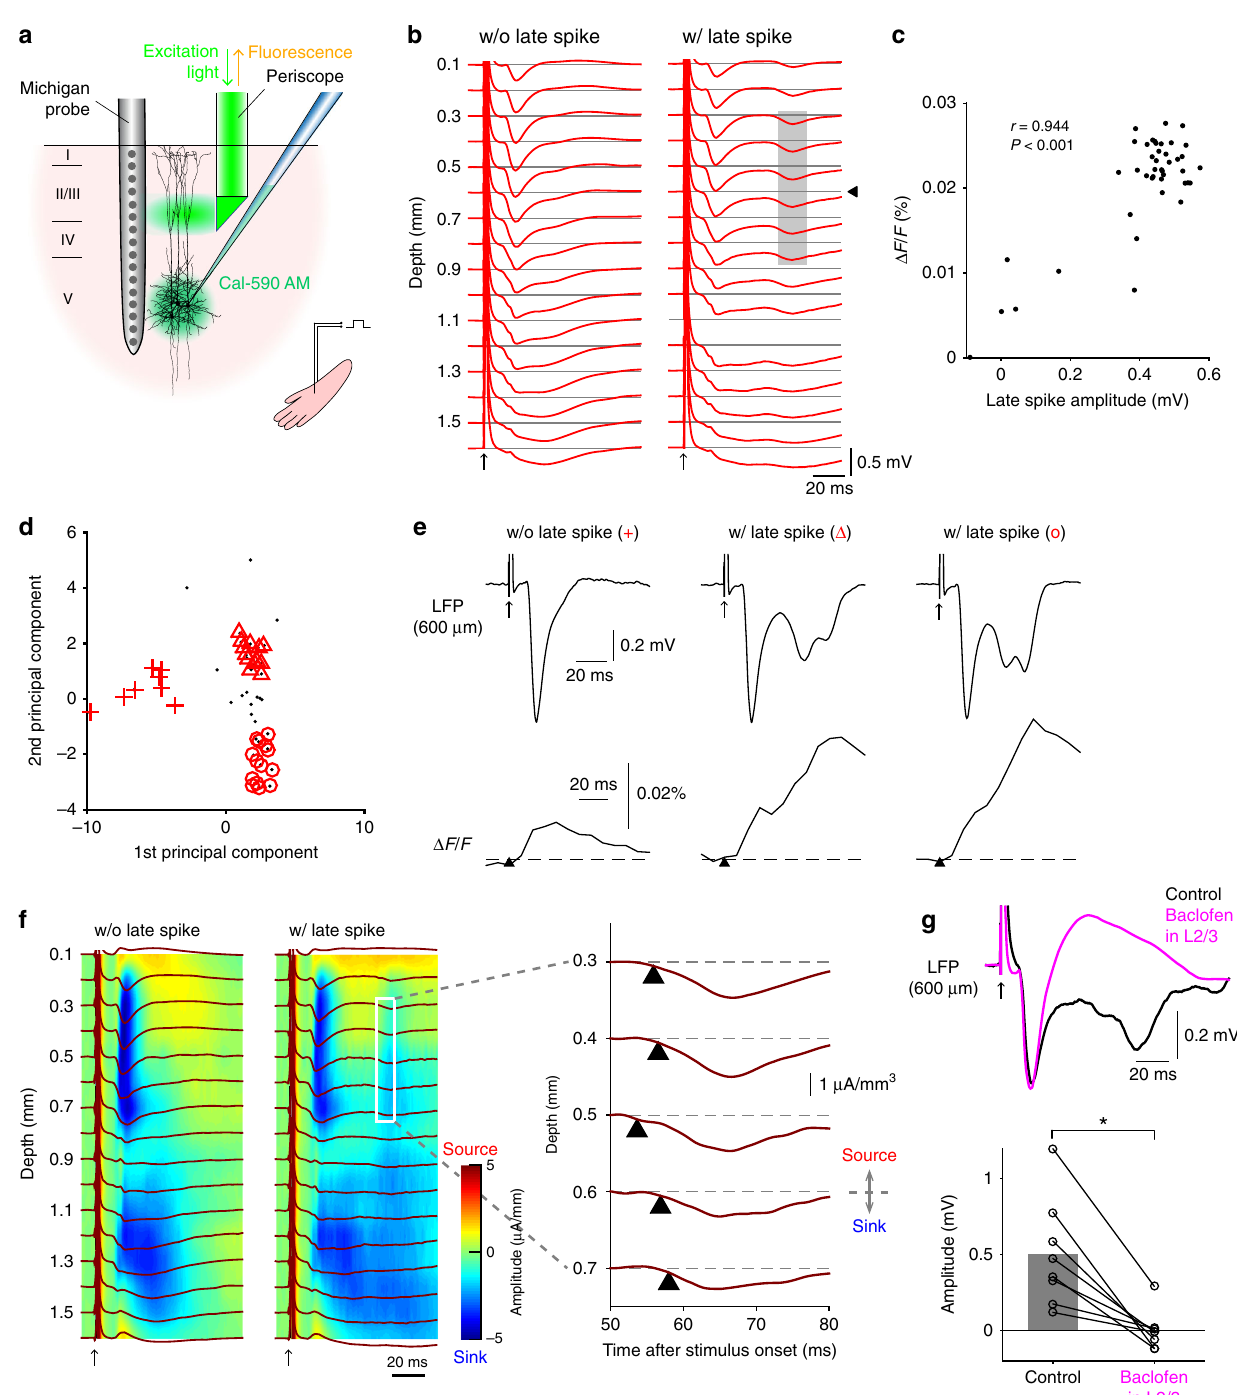
Fig. 5 Sensory-evoked dendritic Ca 2+ spikes. a Schematic diagram of the experiment. b Sensory-evoked potentials with or without late sink. The late sink was considered present if the peak amplitude exceeded 3× s.d. of the prestimulus activity. Shaded area indicates the late sink. The late sink was present in all rats ( n = 8). c Correlation between the LFP amplitude of the late sink at 600 μ m below the pia and dendritic Ca 2+ transients ( p < 0.05 in all animals). d Principal component analysis of 100 waveforms recorded at 600 μ m below the pia (indicated by arrow head in b ) in a representative animal. e Simultaneously recorded LFPs ( top ) and Ca 2+ transients ( bottom ). From left to right : those without discernable late sink; those with smaller late sink; those with larger late sink (from part d ). f CSD pro fi les of sensory-evoked potentials with ( left ) or without ( middle ) the late sink (from part b ) and the expanded view of the CSD pro fi le between 300 μ m and 700 μ m showing that the late sink was initiated at 500 μ m below the pia and then propagated both upward and downward ( right ). g The late sink ( black , average over all 100 traces) was abolished by 50 μ M baclofen ( magenta , average of 100 traces) shown in a single case ( top ) and for all rats ( bottom ; p < 0.05, Wilcoxon signed-rank test, n =